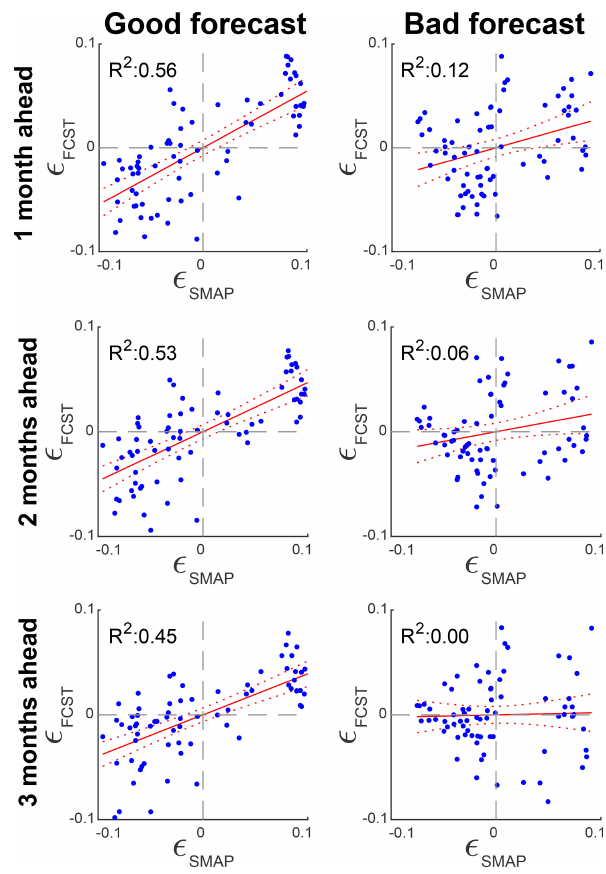
Figure 4. Scatter plots of soil moisture residuals for two sets of sample grid cells with good and bad forecasting skills. The residuals are centered around the mean of SMAP